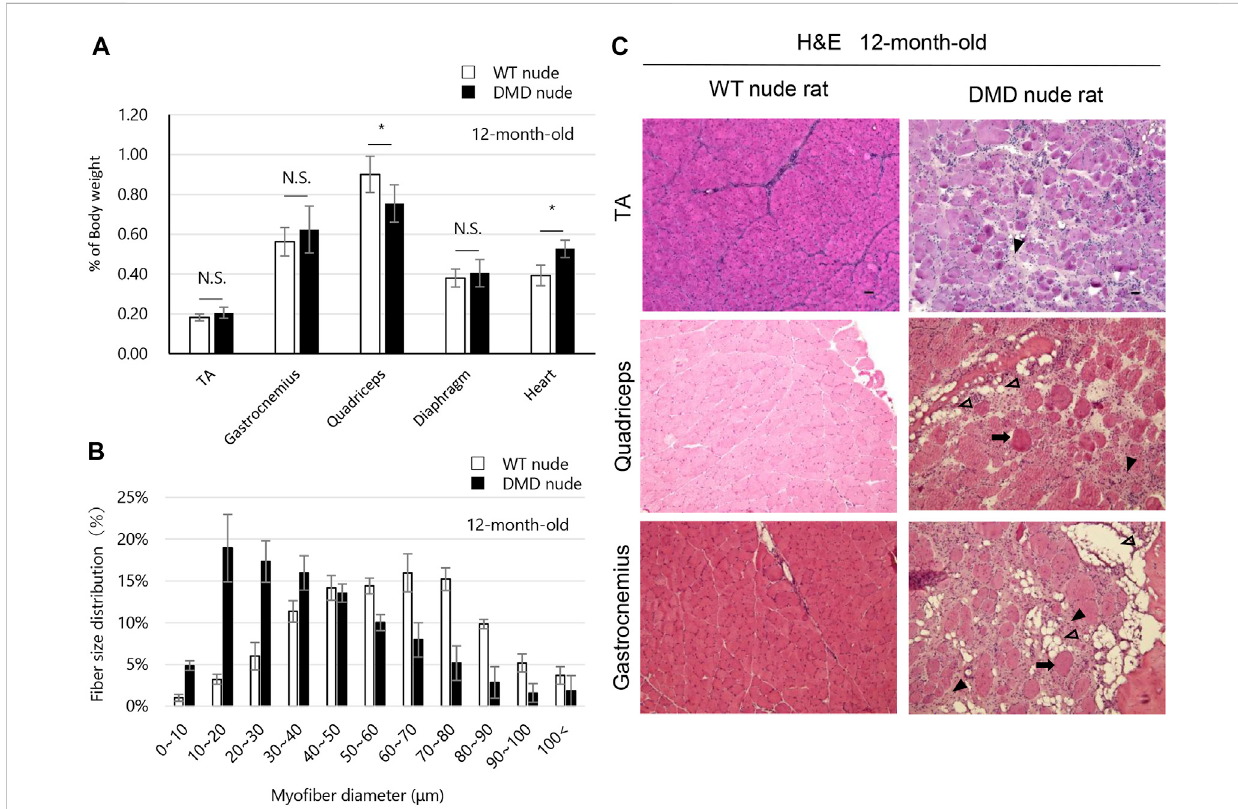
FIGURE 2 PhenotypicanalysisoftheskeletalmusclesofDMDnuderats. (A) Thepercentageofbodyweightrepresentedbyeachmuscletissueattheindicated agesinWTandDMD nuderats.N.S. non-signi fi cant,* p < 0.05. (B) Histologicalchangesinthe fi berdiameter in12-month-oldWTandDMDnuderats. (C) Representativeimagesofhematoxylin&eosin(H&E)stainingofthetibialisanterior(TA),quadriceps,andgastrocnemiusmusclesectionsin12-month-old WT and DMD nude rats. The symbols, ➡ , ▼ , and ▽ , indicate necrotic myo fi bers, fi brosis, and adipogenesis, respectively. Scale bar = 50